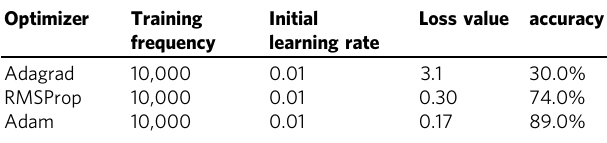
Table 1 Optimizers and their